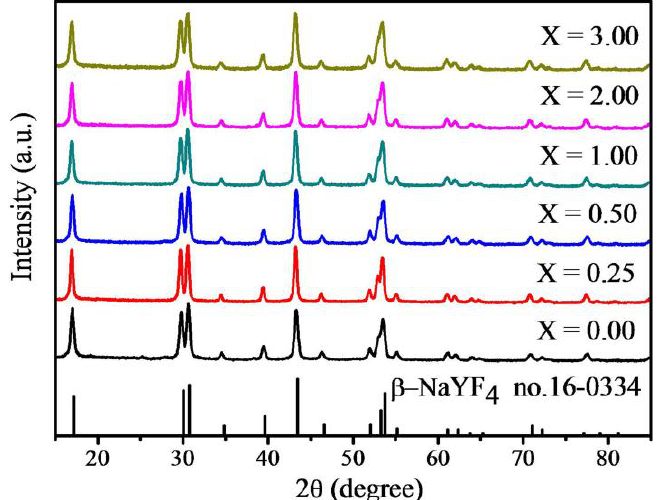
Figure 3. XRD pattern of the as-synthesized NaYF 4 : Yb/Er/Nd (20/2/ X mol%) nanoparticles.